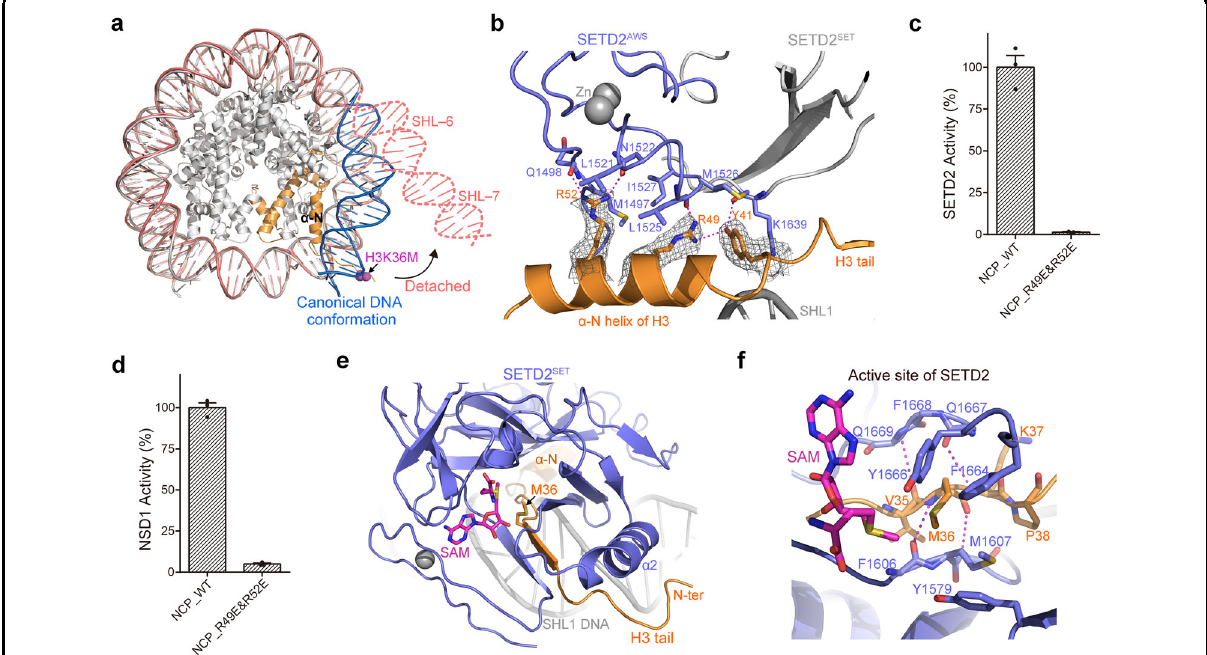
Fig. 2 Interactions in the human SETD2 – hNCP H3.3K36M complex. a Nucleosome DNA at SHL-6 and SHL-7 is detached from the core histones in the SETD2 – hNCP H3.3K36M complex structure. b Detailed view of the recognition interface between SETD2 AWS and the α -N helix of histone H3.3. c Endpoint HMT assays carried out with wide-type or mutant hNCP, revealing that mutations of Arg49 H3.3 and Arg52 H3.3 to Glu drastically diminished the enzymatic activities of SETD2 towards hNCP. The HMT activities were reported for equal amounts of the SETD2 proteins. Error bars correspond to the SD of three replicate assays. Input of the HMT reactions is shown in Supplementary Fig. S4a. d Endpoint HMT assays carried out with wide-type or mutant hNCP, revealing that mutation of Arg49 H3.3 and Arg52 H3.3 to Glu severely impaired the enzymatic activities of NSD1 towards hNCP. The HMT activities were reported for equal amounts of the NSD1 proteins. Error bars correspond to the SD of three replicate assays. Input of the HMT reactions is shown in Supplementary Fig. S4c. e Path of the histone H3.3 tail along the SHL1 DNA, the active site and the α 2 helix of SETD2. f Detailed view of the active site of SETD2 bound with the K36M